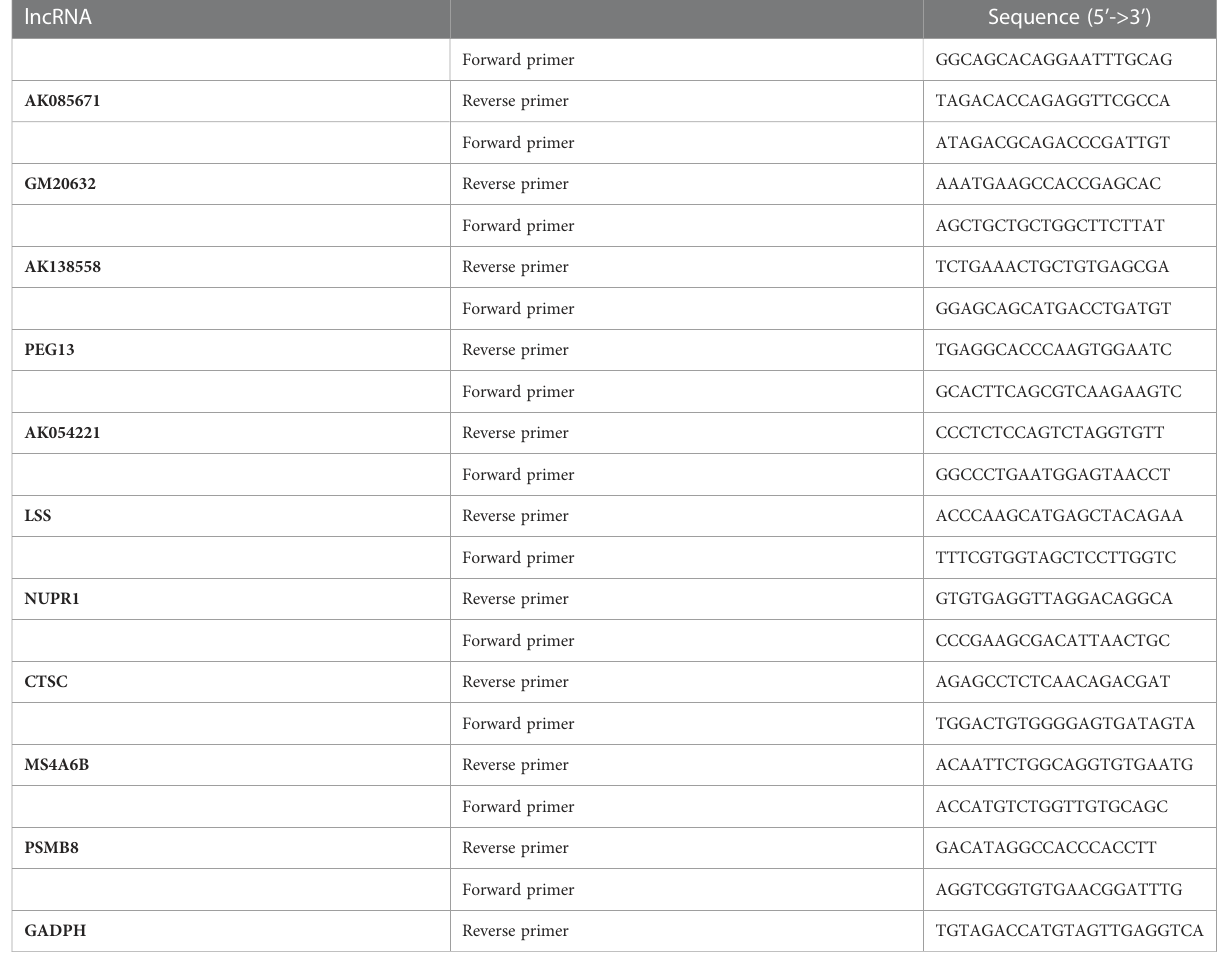
TABLE 2 Primer sequences chosen for the qRT ‒ PCR experiments.